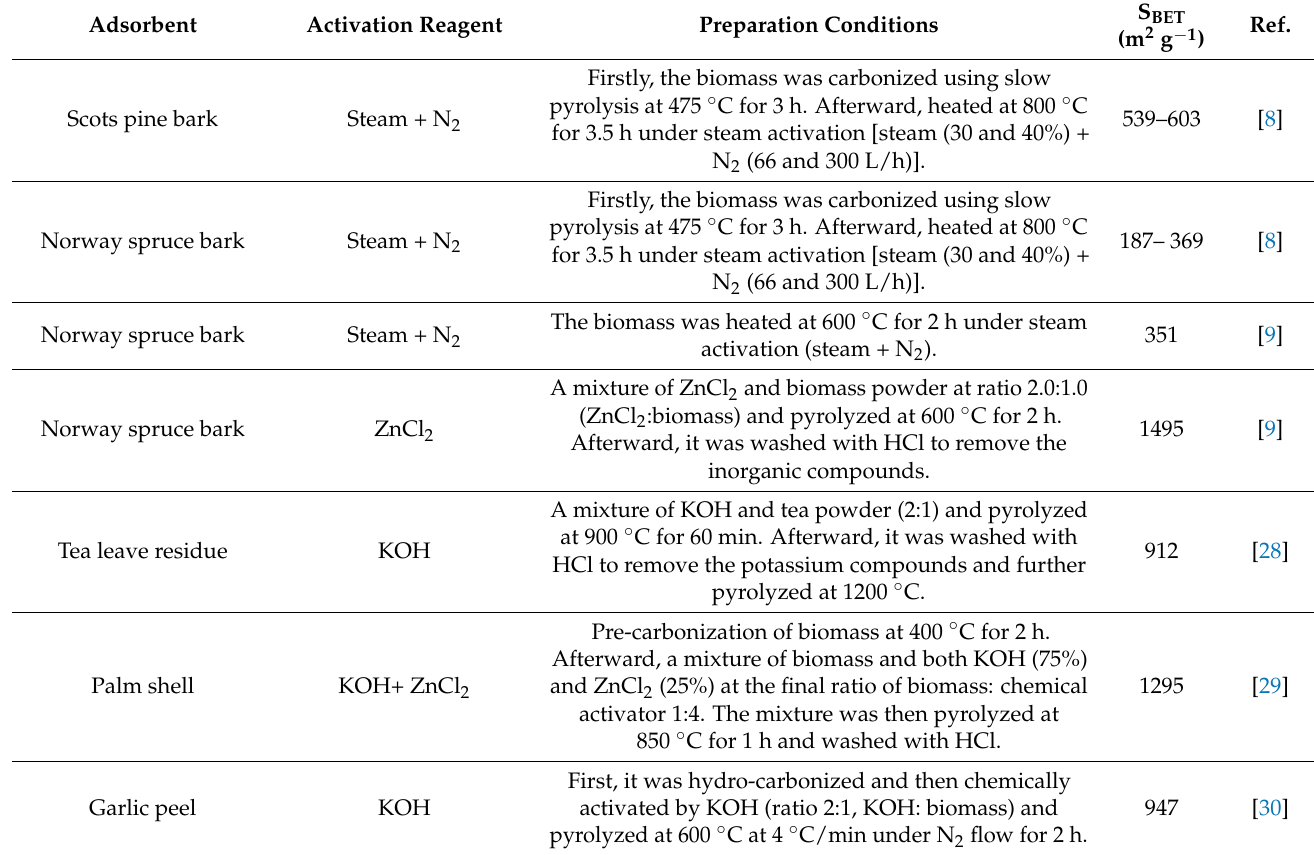
Table 3. Comparison of KOH-BBC and ZnCl2-BBC preparation methods and S BET for a variety of biomass precursors.